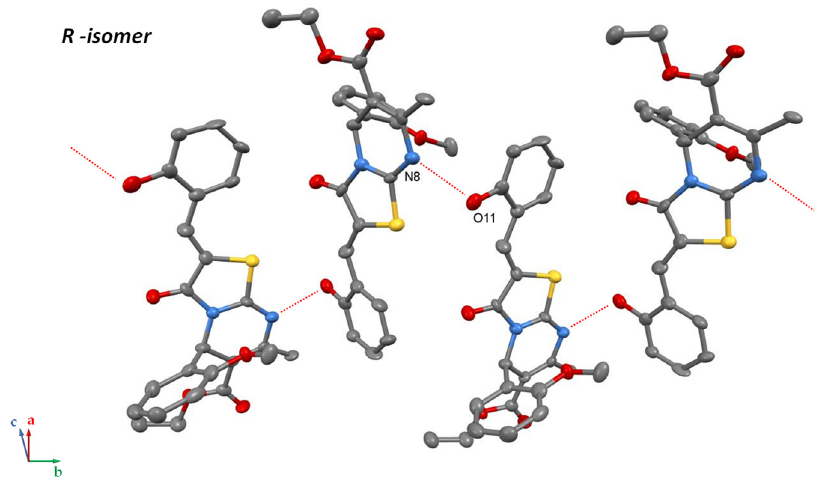
Figure 7. Portion of homochiral crystal structure of 3 , showing formation of 1D H-bonded zigzag chain composed of only R-isomer molecules (view along the b axis). Hydrogen bonds are shown in red dotted lines.